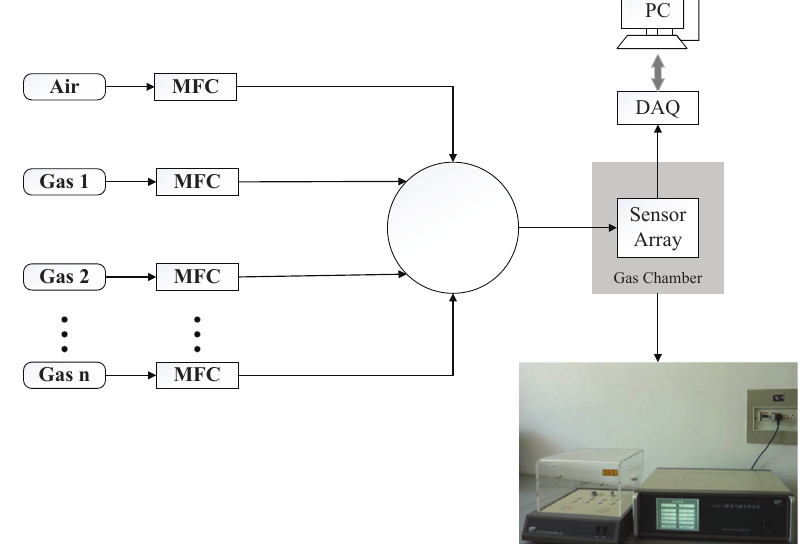
Figure 2. Experimental setup to acquire signatures of the target gases with the sensor